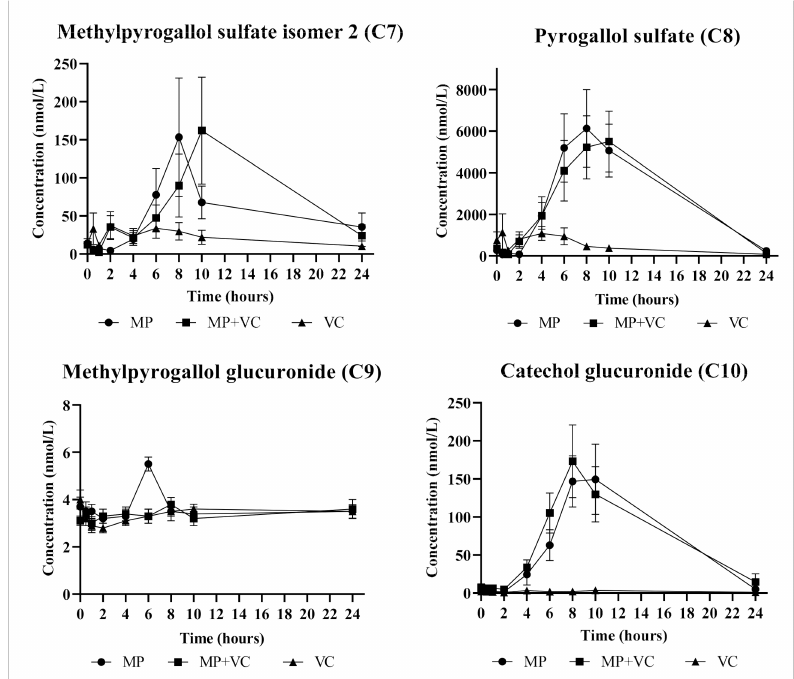
Figure 1. Plasma concentration vs. time profiles (0 − 24 h) of (poly)phenolic compounds and their metabolites: gallic acid ( C1 ), galloyl glucose ( C2 ), methylgallic acid ( C3 ), methylgallic acid sulfate ( C4 ), ferulic acid hexoside ( C5 ), methylpyrogallol sulfate isomer 1 ( C6 ), methylpyrogallol sulfate isomer 2 ( C7 ), pyrogallol sulfate ( C8 ), methylpyrogallol glucuronide ( C9 ) and catechol glucuronide ( C10 ), after test beverages intake. MP (mango pulp), MP + VC (mango pulp + vitamin C) and VC (vitamin C).